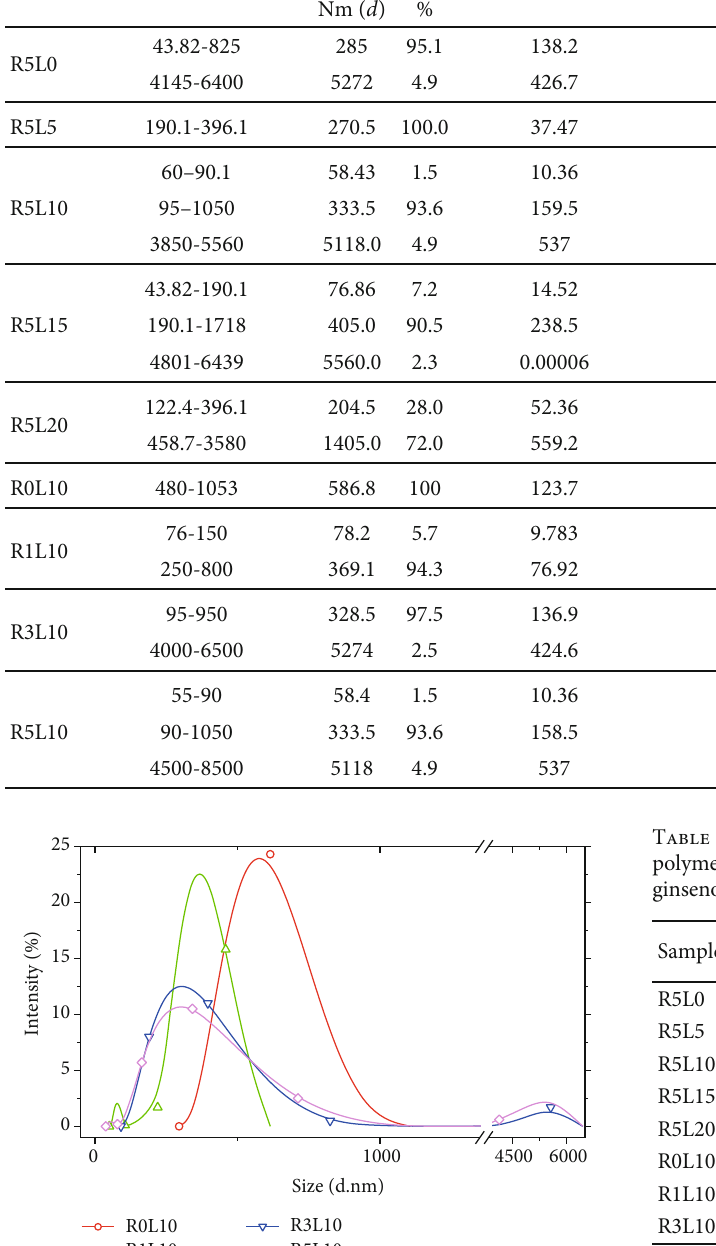
Table 5: Particle size of NPB using di ff erent Lov and ginsenoside Rb1 content. Sample Particle size range (nm)